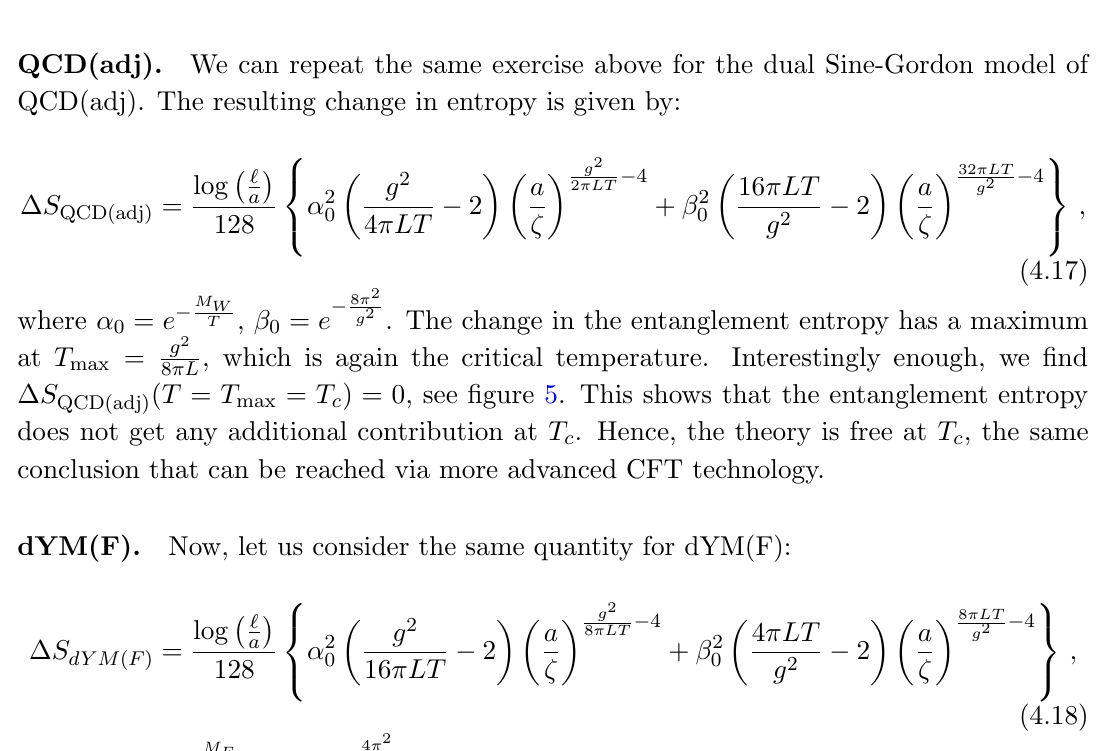
4 (cid:25)LT . Left: (cid:1) S of QCD(adj). (cid:1) S attains g 2 (cid:17)